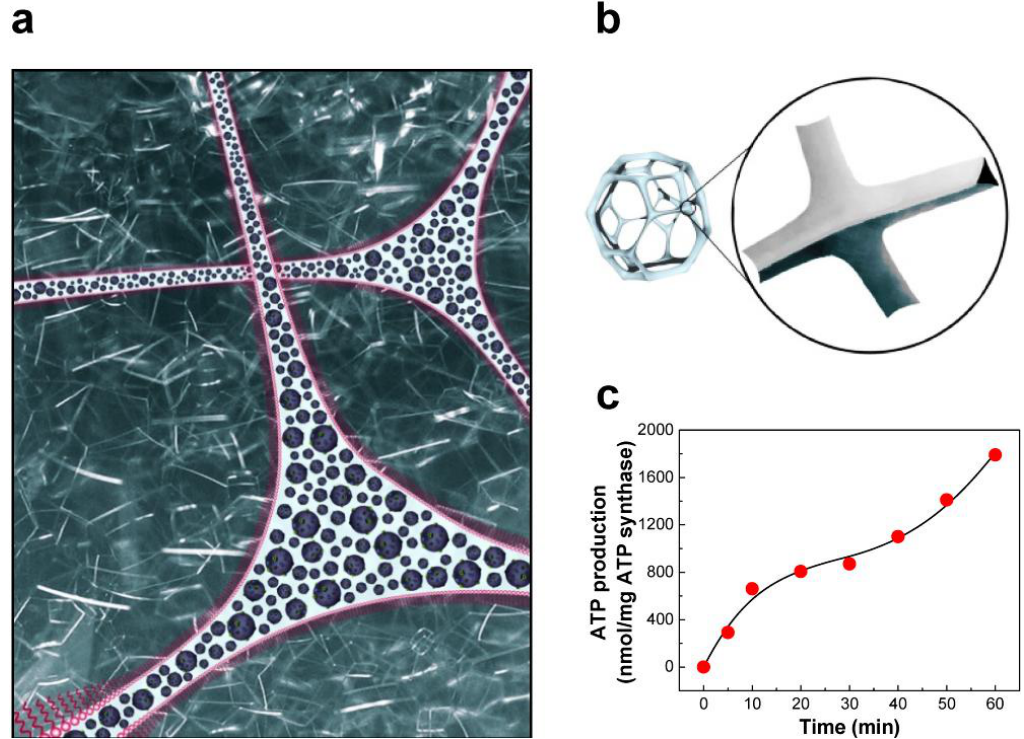
Figure 10. ( a ) Foam architecture as a platform for a bioreactor; ( b ) Plateau border of